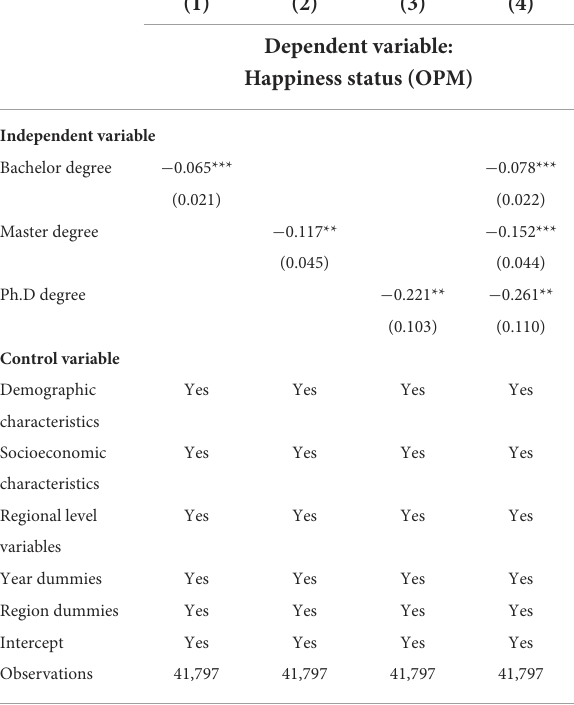
TABLE 14 Relationship between different degrees and happiness